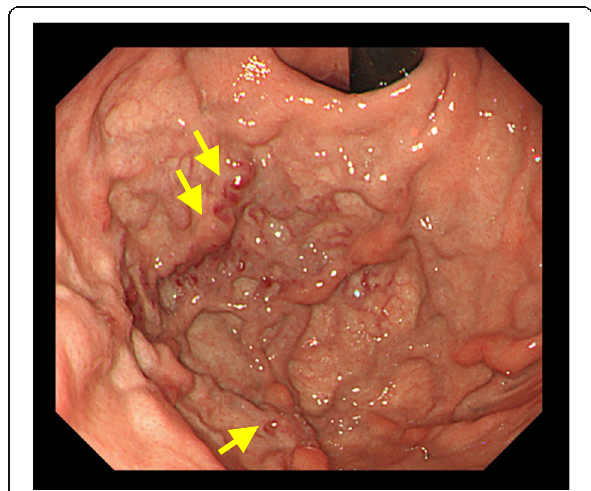
Fig. 1 Upper gastrointestinal endoscopy showed isolated varices in the gastric fundus